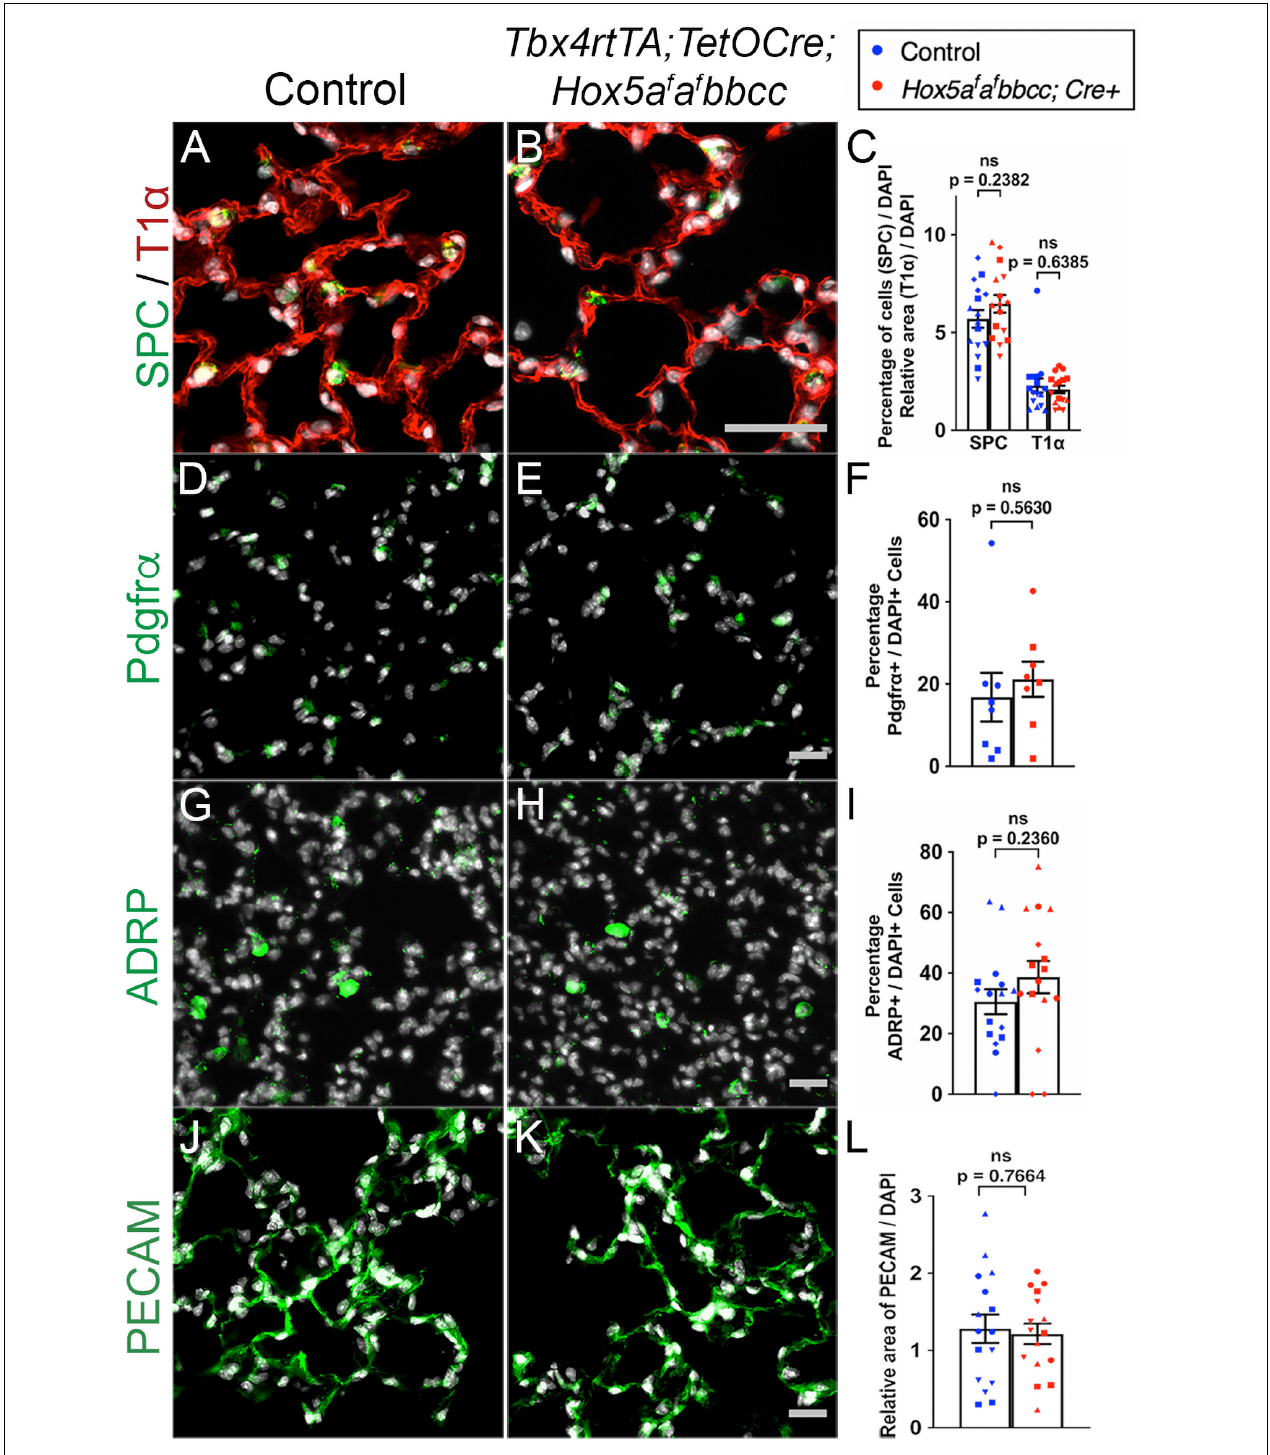
FIGURE 3 | Distal lung cell types are present and appear similar in controls and Hox5 conditional mutants. Lung paraffin sections (A,B,G,H,J,K) and cryosections (D,E) of control and Hox5 adult, conditional mutant mice show similar expression of SPC (green, AECII cells), T1 α (red, AECI cells), PDGFR α (green, fibroblasts), ADRP (green, lipofibroblasts) and PECAM (green, endothelial cells); DAPI in gray. Quantification of pixel intensity of T1 α (C) , and PECAM (L) were normalized to pixel intensity of DAPI per field image. Quantifications of SPC (C) , PDGFR α (F) and ADRP (I) cell numbers were normalized to DAPI-positive cell numbers in each panel quantified. Each shape represents an individual animal (ns, not significant). Scale bars: 50 µ m. P -values were determined by an unpaired Student’s t -test.